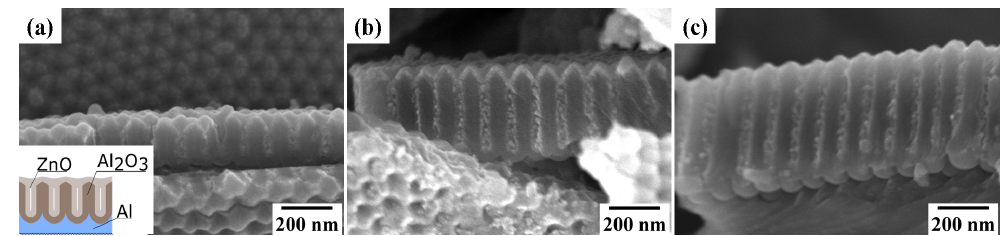
Figure 1. ( a – c ) Cross section SEM images of variable-thickness ZnO NR–PAAO hybrid film from the same sample at different positions (x coordinates). The inset shows a schematic of the sample morphology.